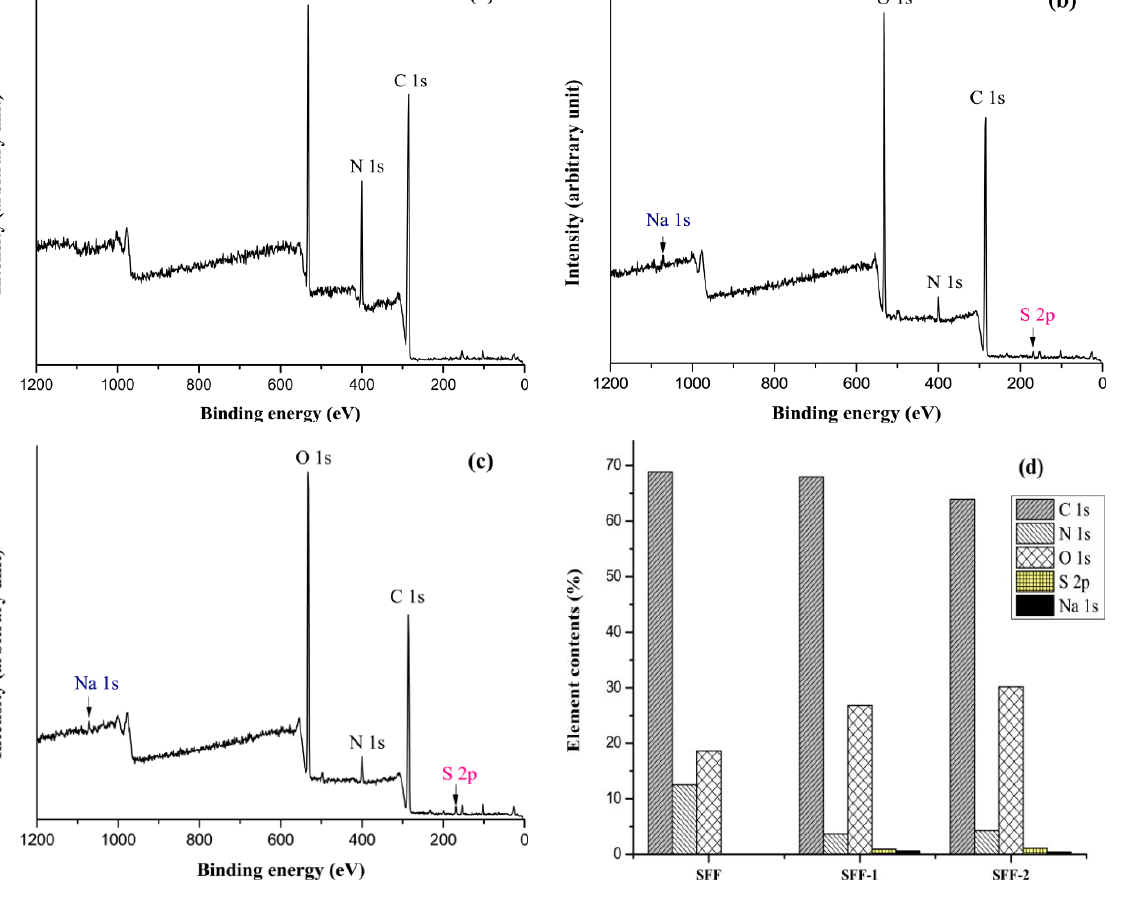
Figure 7. XPS spectra of S 2p peaks: ( a ) SFF-1 and ( b )